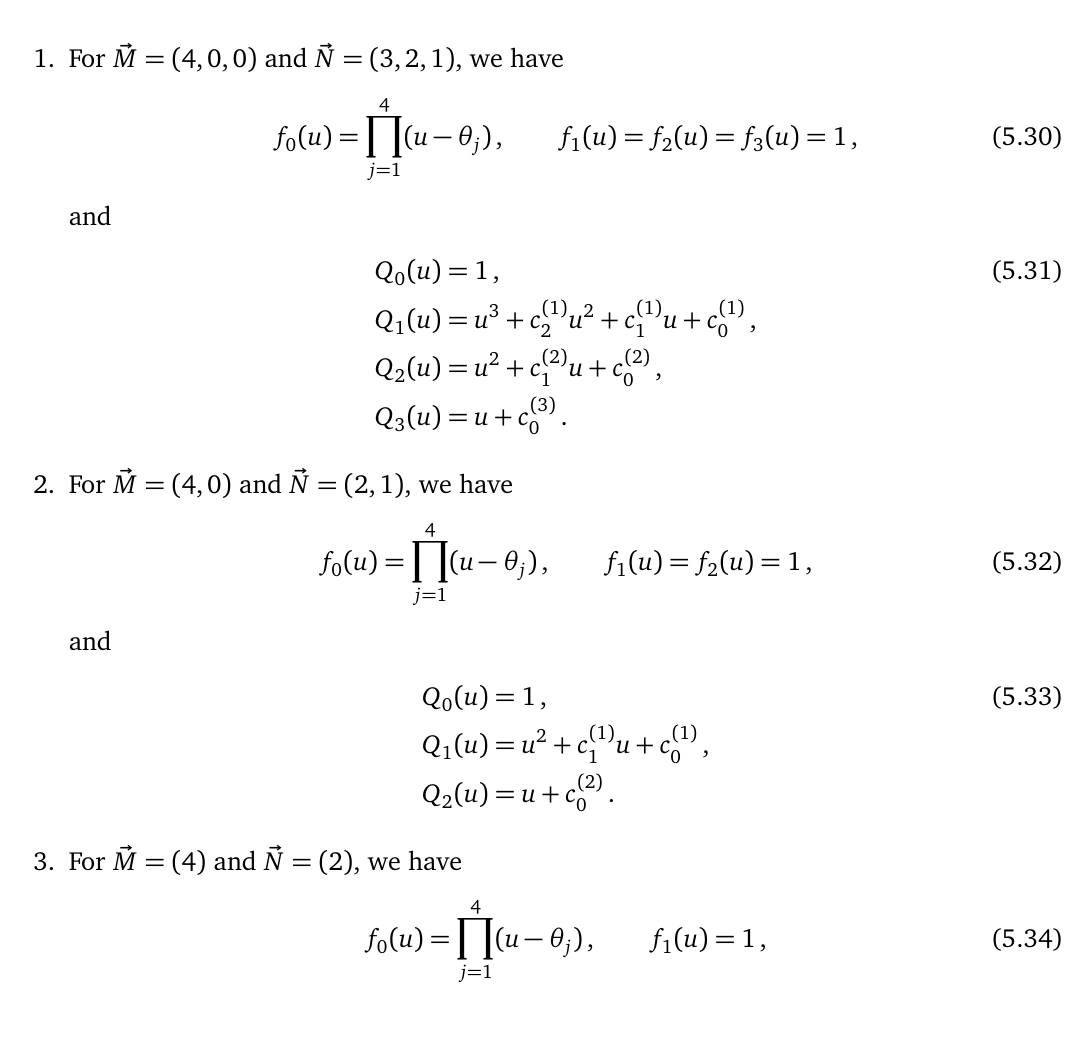
-type rational Q 3